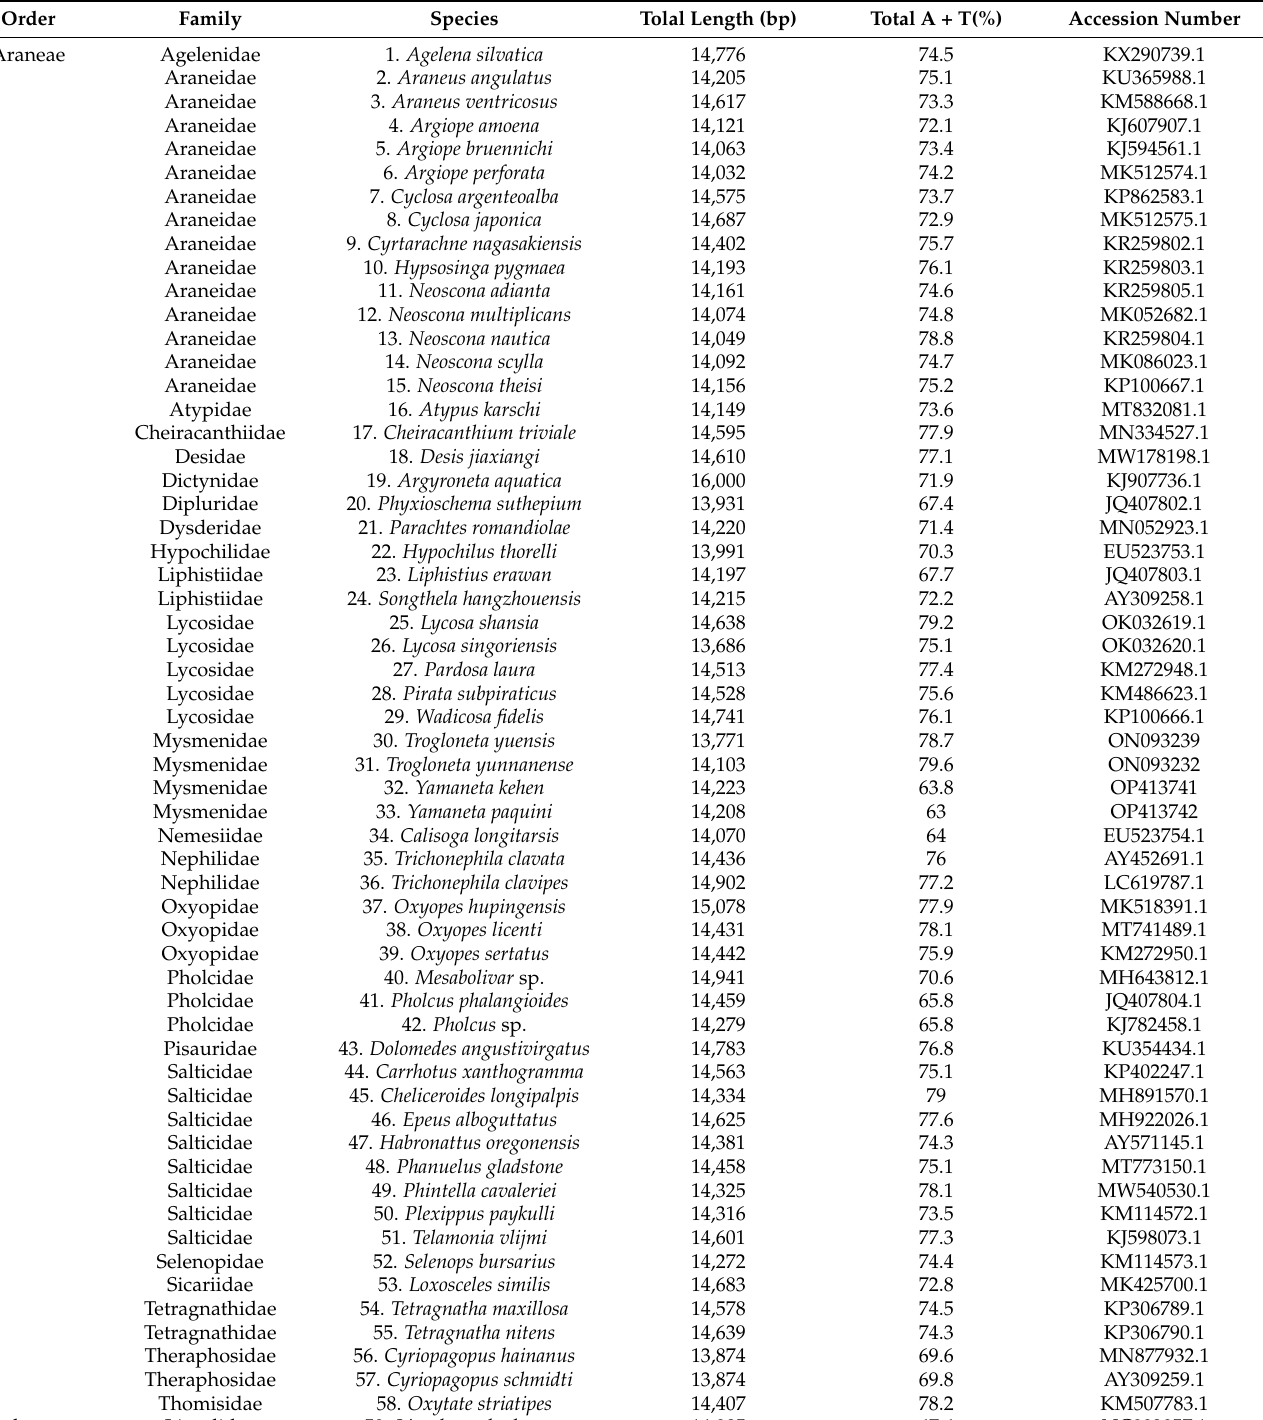
Table 2. Summary of the mitogenomes used for phylogenetic